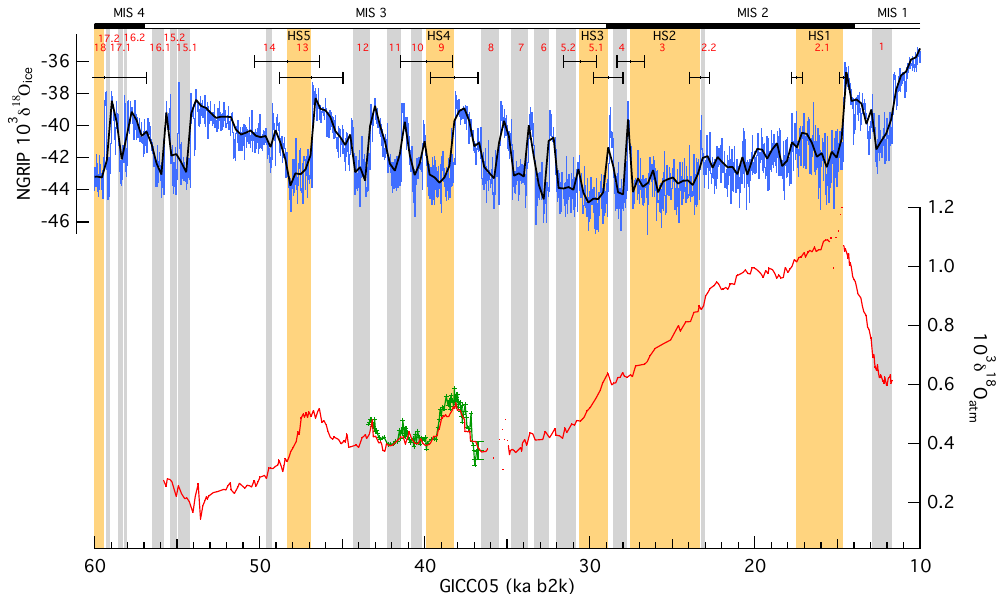
Figure 1. Greenland stadials and Heinrich stadials during the last glacial period. Red numbers indicate GSs and black labels HSs. (a) Black line: NGRIP δ 18 O, ‰, on the GICC05 timescale back to 60ka b2k. (b) Red line: Siple Dome atmospheric δ 18 O (Severinghaus et al., 2009) on GICC05 timescale. Red dots denote intervals in the core where deep air convection or cracked firn layer may have thermally fractionated these samples, as shown by anomalous δ 15 N in Figs. S1 and S8 of Severinghaus et al. (2009). The transfer of Siple Dome atmospheric δ 18 O on the GICC05 chronology is achieved by using the Siple Dome gas age scale compatible with the GICC05 chronology (Guillevic, 2013), based on match points between Siple Dome methane variations (Brook et al., 2005; Ahn et al., 2012; depth point) and NEEM methane variations (Chappellaz et al., 2013; GICC05 gas age point). A linear interpolation is then performed between match points to calculate the Siple Dome gas age. Green line: NEEM atmospheric δ 18 O, ‰ ( ± 0 . 03‰; Guillevic et al., 2014). Colored areas: GSs. Grey: GS with no major Heinrich event. Orange: HS1, HS2, HS3, HS4, HS5 and end of HS6 – GSs with a major Heinrich event. Black error bars indicate HS onset and end uncertainty (2 σ ), based on the Rasmussen et al. (2013) maximum counting error (MCE). Top (right to left): black and white horizontal bar indicate Marine Isotope Stage 1 to 4.